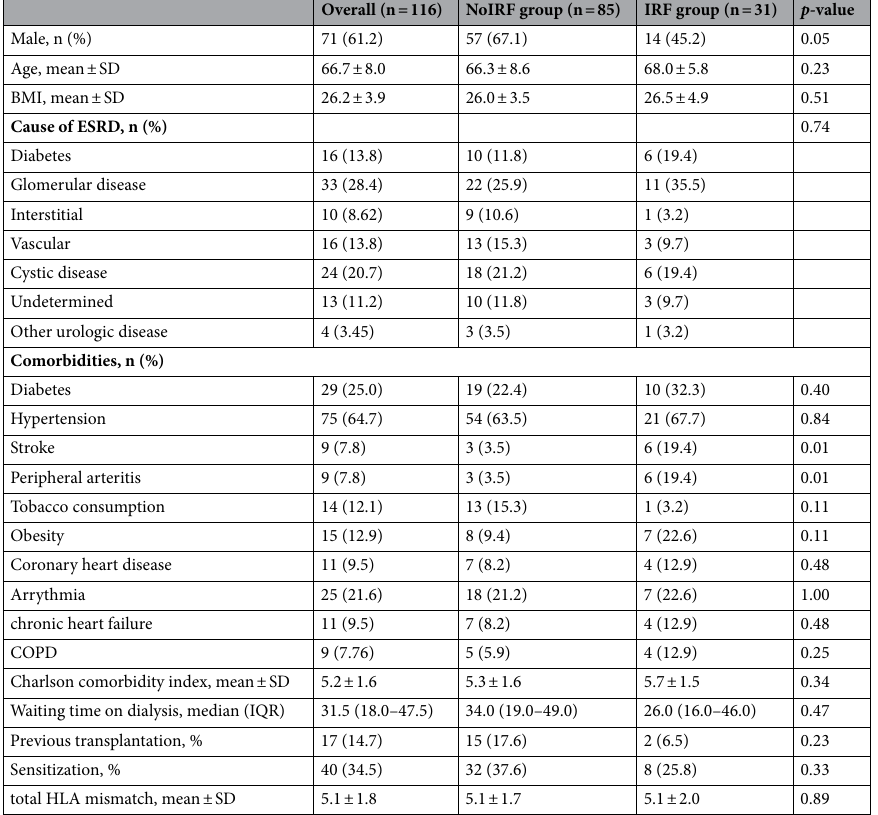
Table 2. Baseline recipients’ characteristics with comparison according to a peak serum creatinine over 1.0 mg/dl and/or a transient oligo-anuria in the donor. For all tests, a p-value < 0.05 was considered